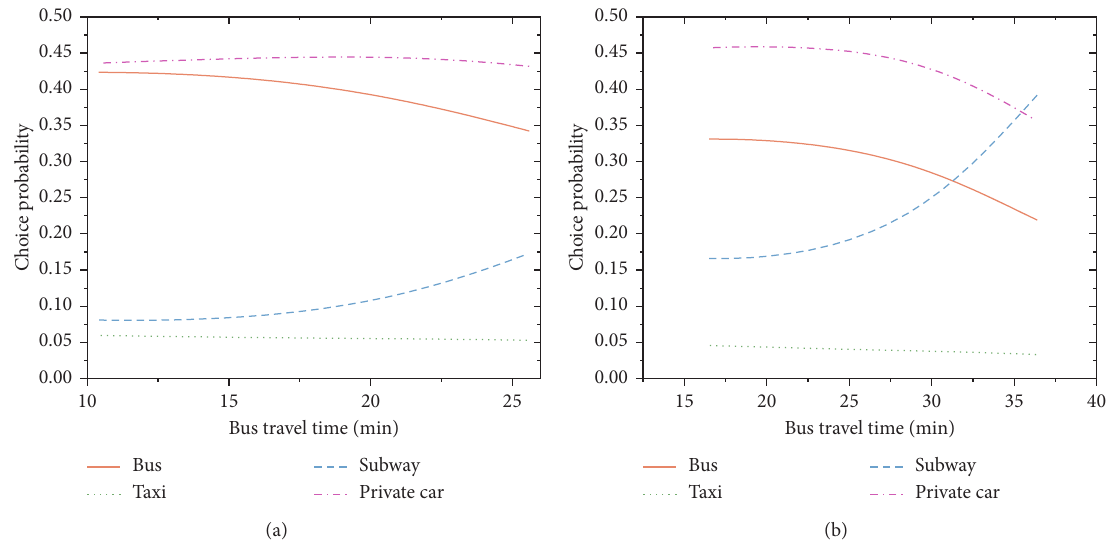
Figure 7: Variation curve of the choice probability with the bus travel time. (a) Short trip. (b) Long trip.